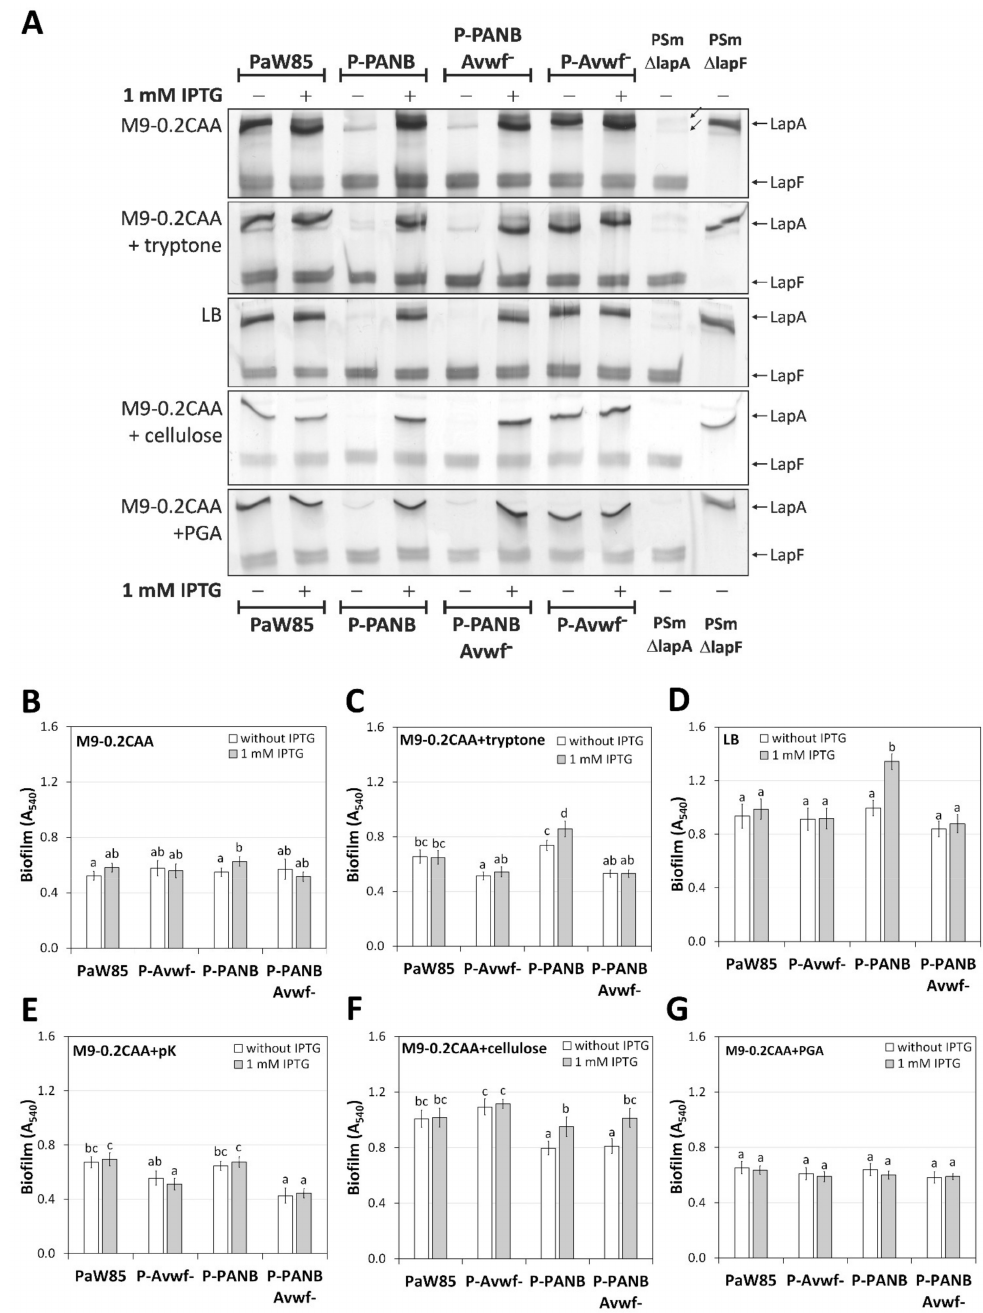
Figure 4. LapA and LapF amount in P. putida PaW85-based strains and biofilm. ( A ) SDS-PAA gel electrophoresis of crude cell lysates, 40 µ g of total protein is loaded to each lane. The media in which cells were grown for preparing crude cell lysates are shown on the left of the gel image. Cells were grown with and without 1 mM IPTG. The strains used in the analysis are shown above and below the figure. PSm ∆ lapA and PSm ∆ lapF strains were used as negative controls for LapA and LapF. Arrows indicate LapA and LapF on the right side of the figure. Inclined arrows indicate an unknown protein complex. ( B ) Biofilm of PaW85-based strains in M9-0.2CAA, ( C ) M9-0.2CAA+tryptone, ( D ) LB, ( E ) M9-0.2CAA+poly-L-lysine, ( F ) M9-0.2CAA+cellulose and ( G ) M9-0.2CAA+PGA in the presence and absence of 1 mM IPTG. Arithmetical averages of at least three biological parallels with 95% confidence intervals are given. Homogeneity groups are shown above the columns by lower-case letters. Identical letters denote nonsignificant differences ( p ≥ 0.05) between averages of biofilm. Multifactorial ANOVA was used for statistical analysis, analysed separately by